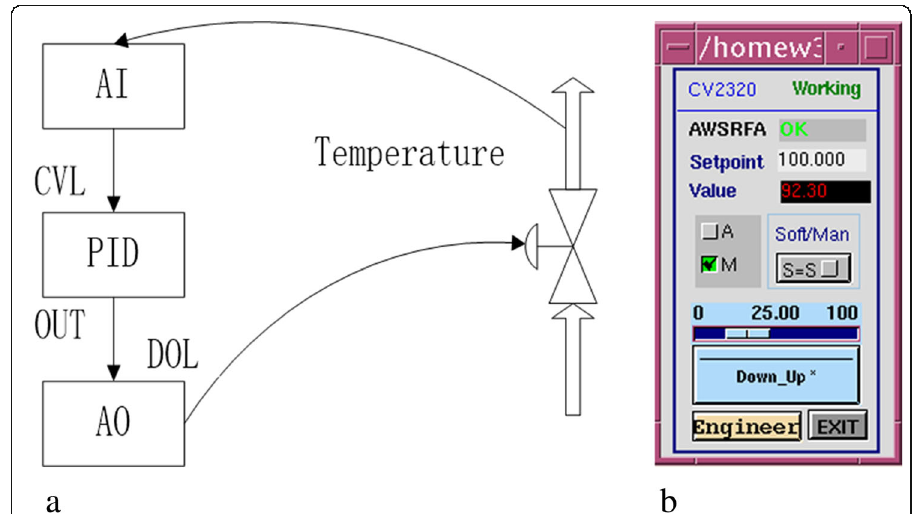
Fig. 9 A typical PID